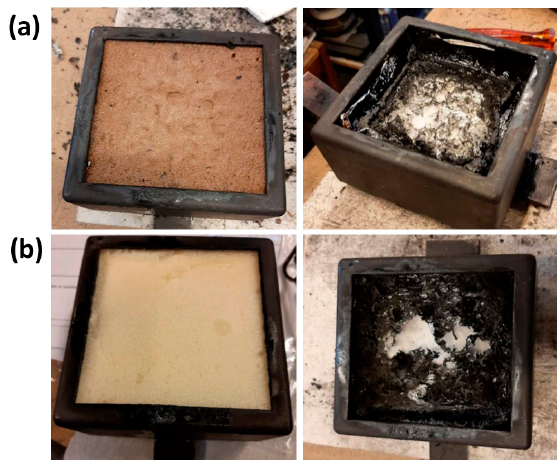
Figure 7. ( a ) bio-based RPUF and ( b ) RPUF-conv before ( left ) and after ( right ) burn. Table 7. Reaction to fire parameters of bio-based RPUF and